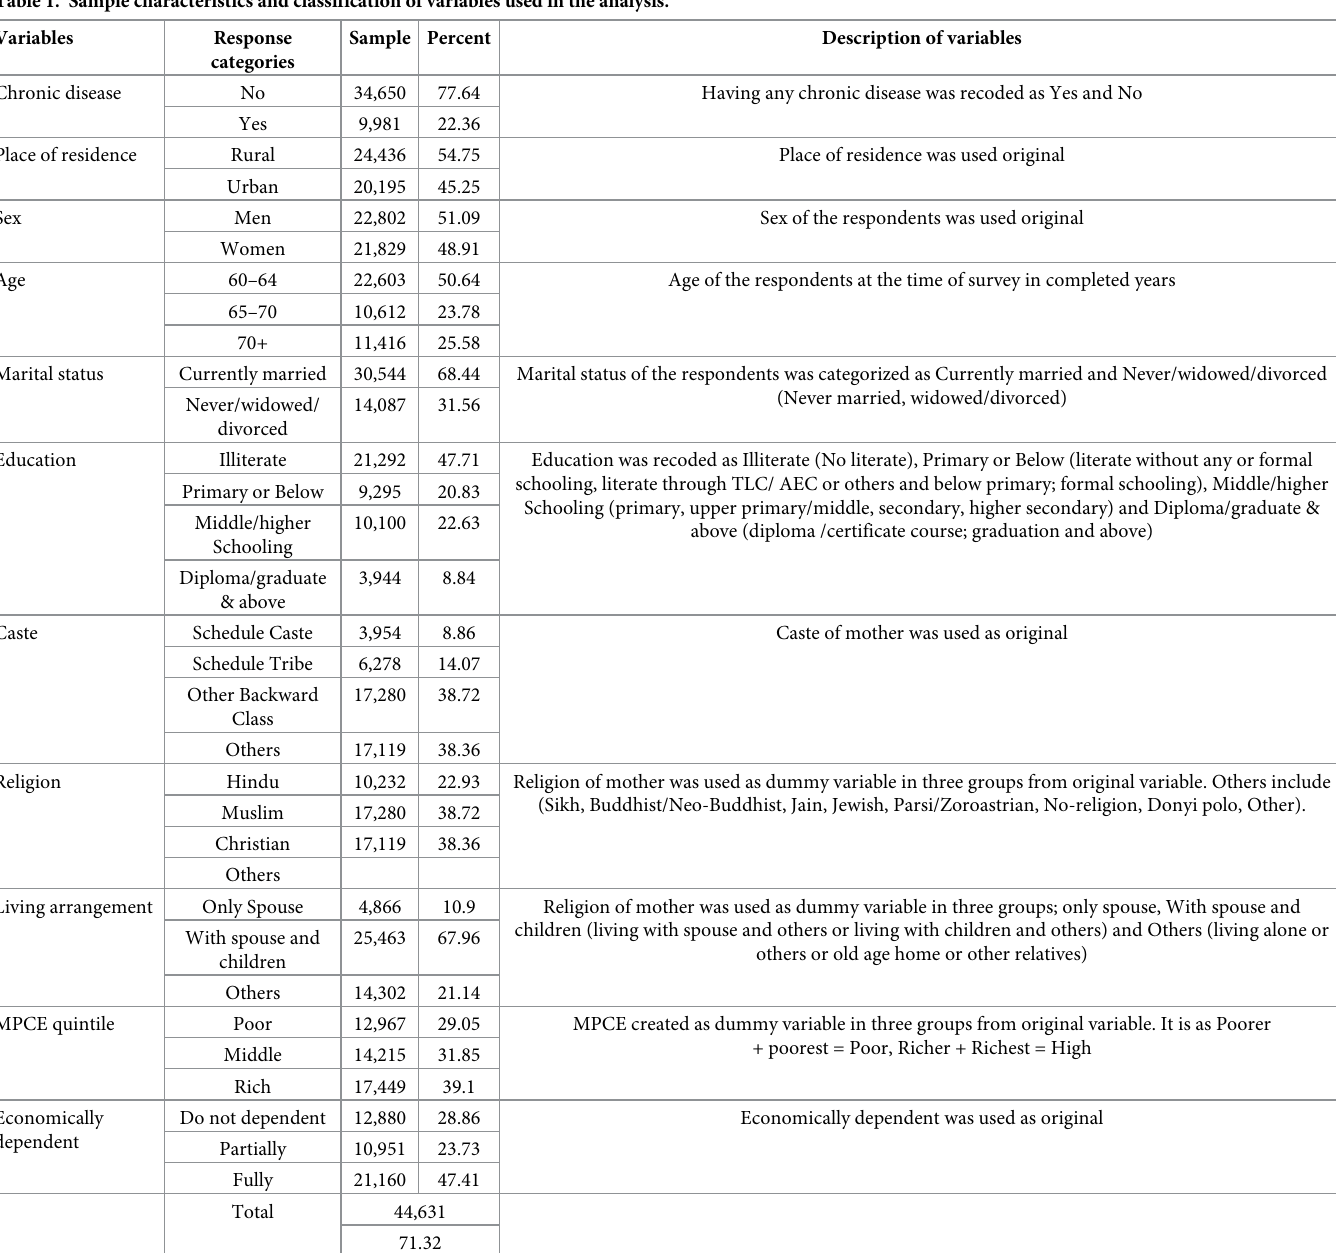
Table 1. Sample characteristics and classification of variables used in the